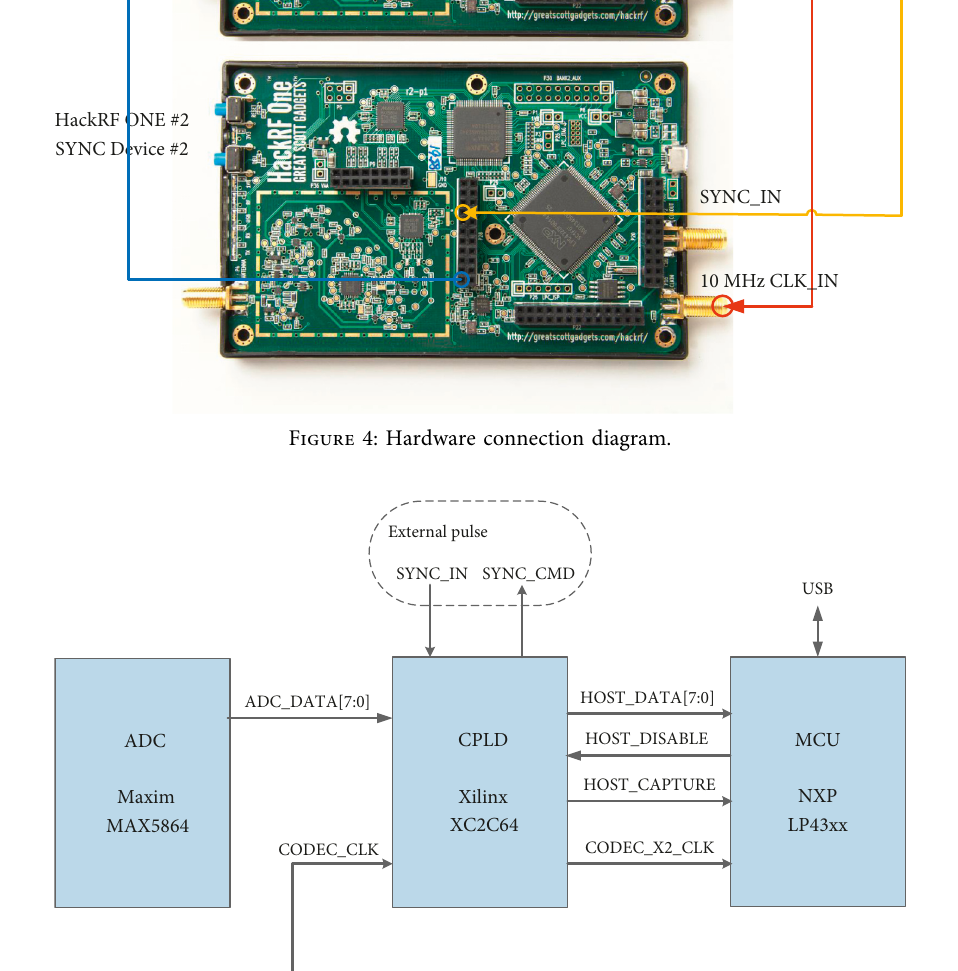
Figure 5: Signals between CPLD and MCU.